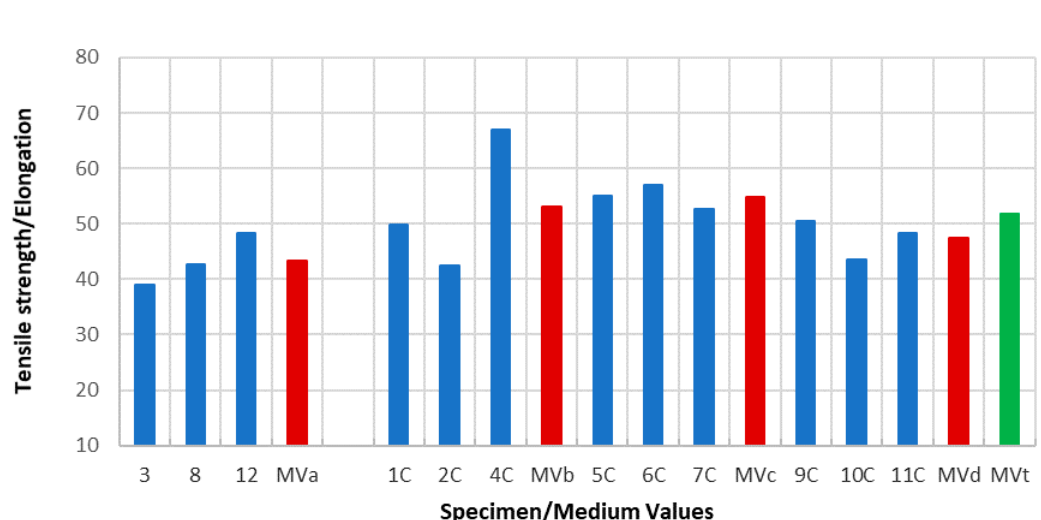
Figure 9. Tensile strength/elongation relation values and medium values.